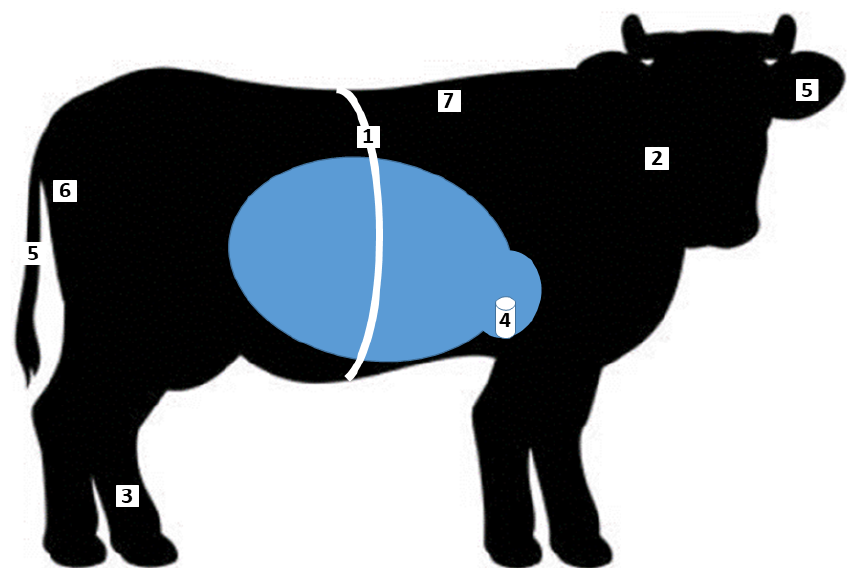
Figure 1. Dairy cattle “at cow” sensors according to Table 1. 1. Body surface ECG equipment, 2. Neck rumination sensor, 3. Leg activity sensor, 4. Rumen sensors, 5. Tail, ear estrus detector, 6. Vaginal partition detector, 7. Subcutaneous sensor. Table 1. Sensor groups according to the placement location and methodology, usage length, aim of data